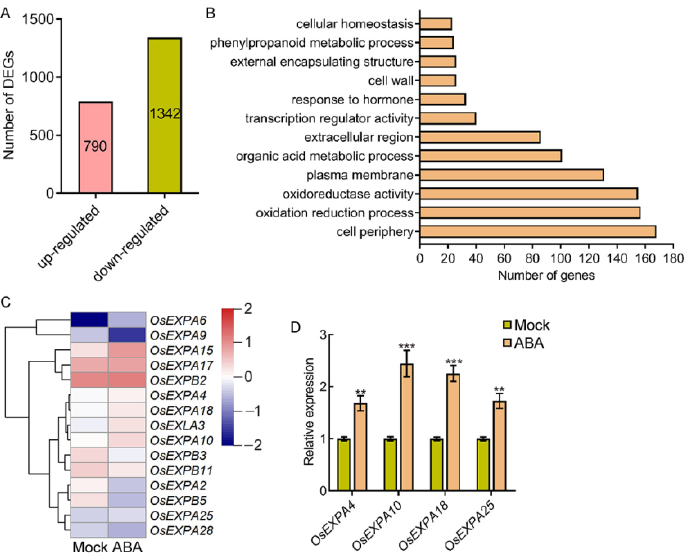
Figure 5. ABA induces the expression of EXPANSIN genes. ( A ) Number of DEGs up- and down- regulated in the root treated with ABA. ( B ) GO term analysis of ABA up- and down-regulated genes. ( C ) Heat-map of the microarray expression profiles of EXPANSIN genes. ( D ) Quantitative polymerase chain reaction (qPCR) analysis of EXPANSIN genes in 4-day-old seedling roots treated with or without 1 µ M ABA for 3 h. Three biological replicates were performed with similar results, and a representative experiment is shown. Samples were collected from three independent experiments. Bars indicate ± SD. The asterisks indicate significant differences compared to Mock (** p < 0.01, *** p < 0.001, Student’s t